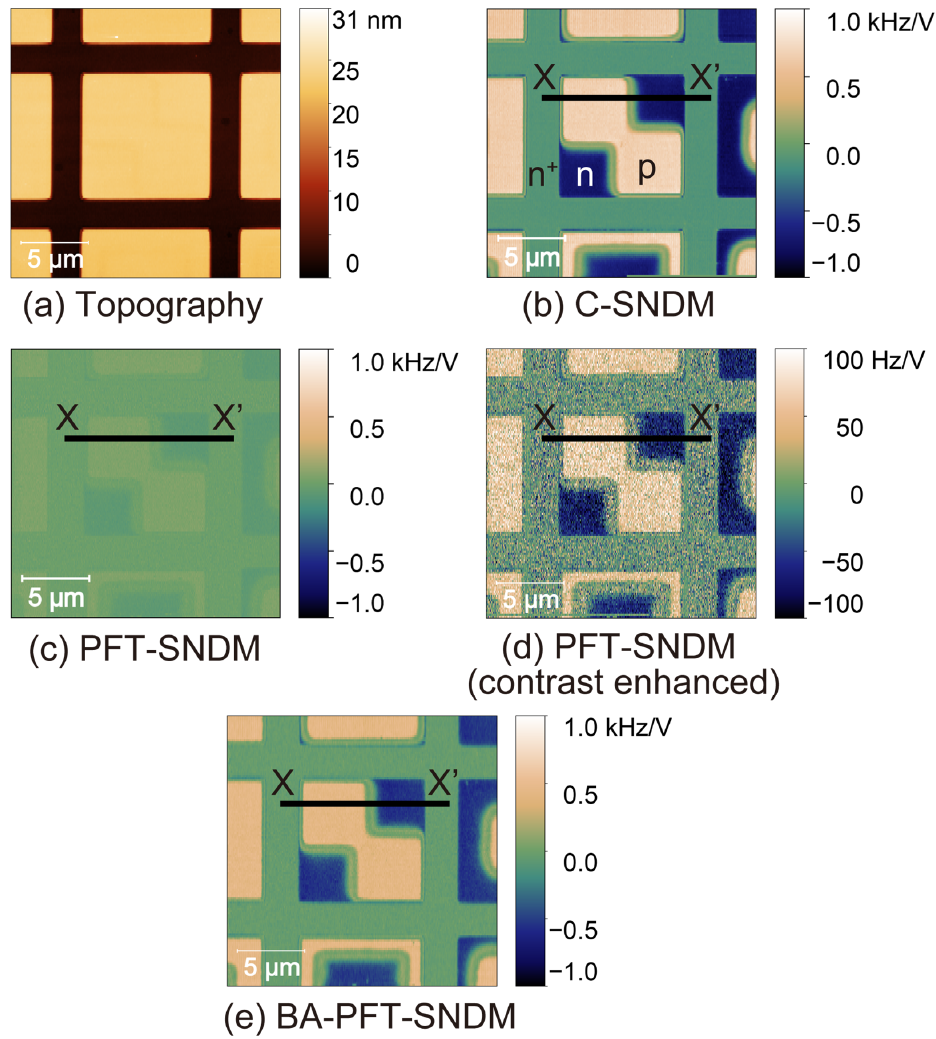
Figure 8. Topographic ( a ), C-SNDM ( b ), PFT-SNDM ( c , d ), and BA-PFT-SNDM ( e ) images for the Si test sample with p-, n-, and n + doped areas. ( d ) is a contrast-enhanced image of ( c ). Profiles across the lines from X to X’ in the images are shown in Figure 9.